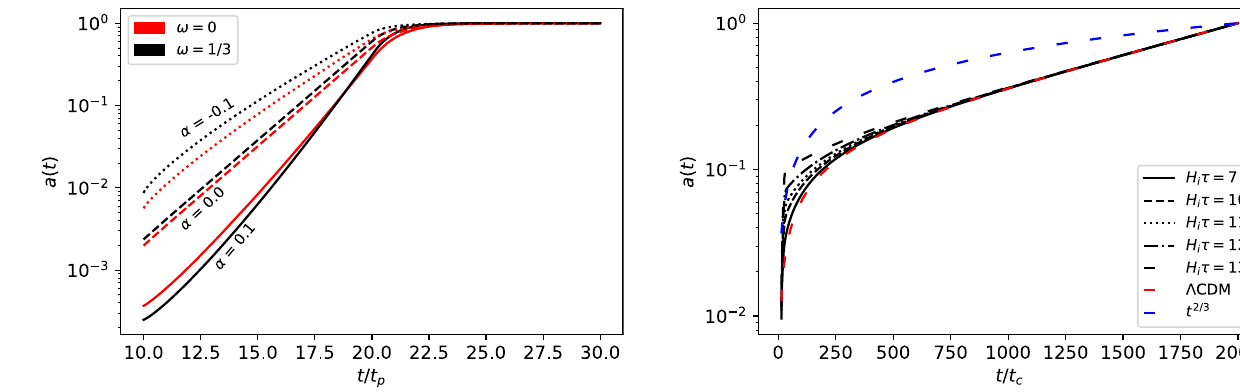
Fig. 3 Some solutions to the time-delayed Friedmann equation in the presence of a cosmological constant and time delay on the order of t c , = 0 . 0175 ± 0 . 0001 Gyr. The integration starts off where t c = H − 1 i with an initial history of φ( t ) ∼ t 2 / 3 in the matter-dominated era